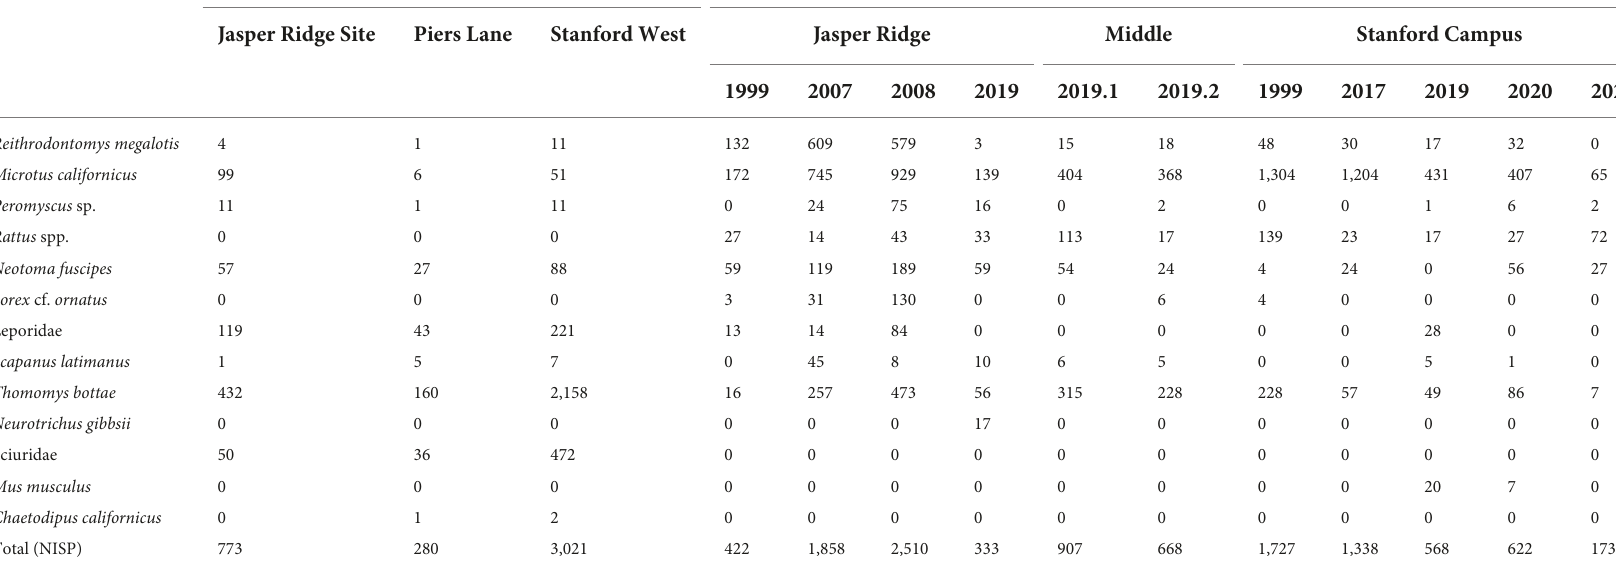
TABLE 1 Small mammal abundances (cranial NISP) in each study area and time